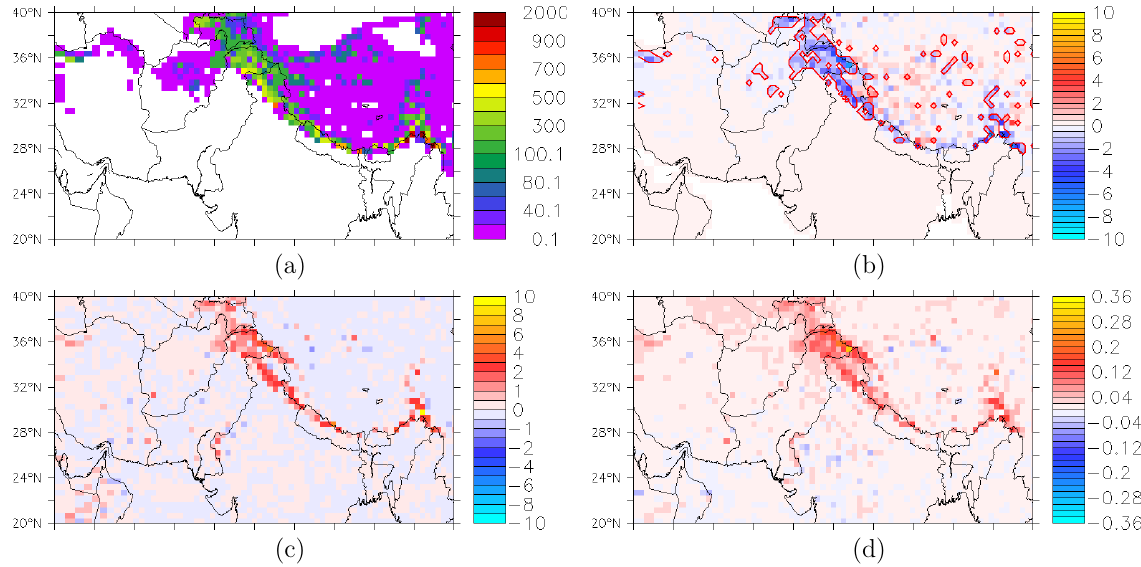
Fig. 3. (a) Simulated spring BC mixing ratio (µgkg − 1 ) in the surface snow layer (8mm SWE). (b) Difference in annual mean of snow cover duration (days per year) between two simulations performed with and without the snow albedo variations induced by BC deposition. Areas with statistically significant differences, according to a two-sample t test, are red-contoured. (c) Same difference but for annual mean net surface solar radiation (Wm − 2 ). (d) Same difference but for annual mean 2m atmospheric temperature ( ◦ C). LMDZ simulations are based on a stretched grid reaching a resolution of ∼ 50km over the Himalayas. Wind fields have been nudged toward the ERA-Interim reanalysis (see details in Sect.